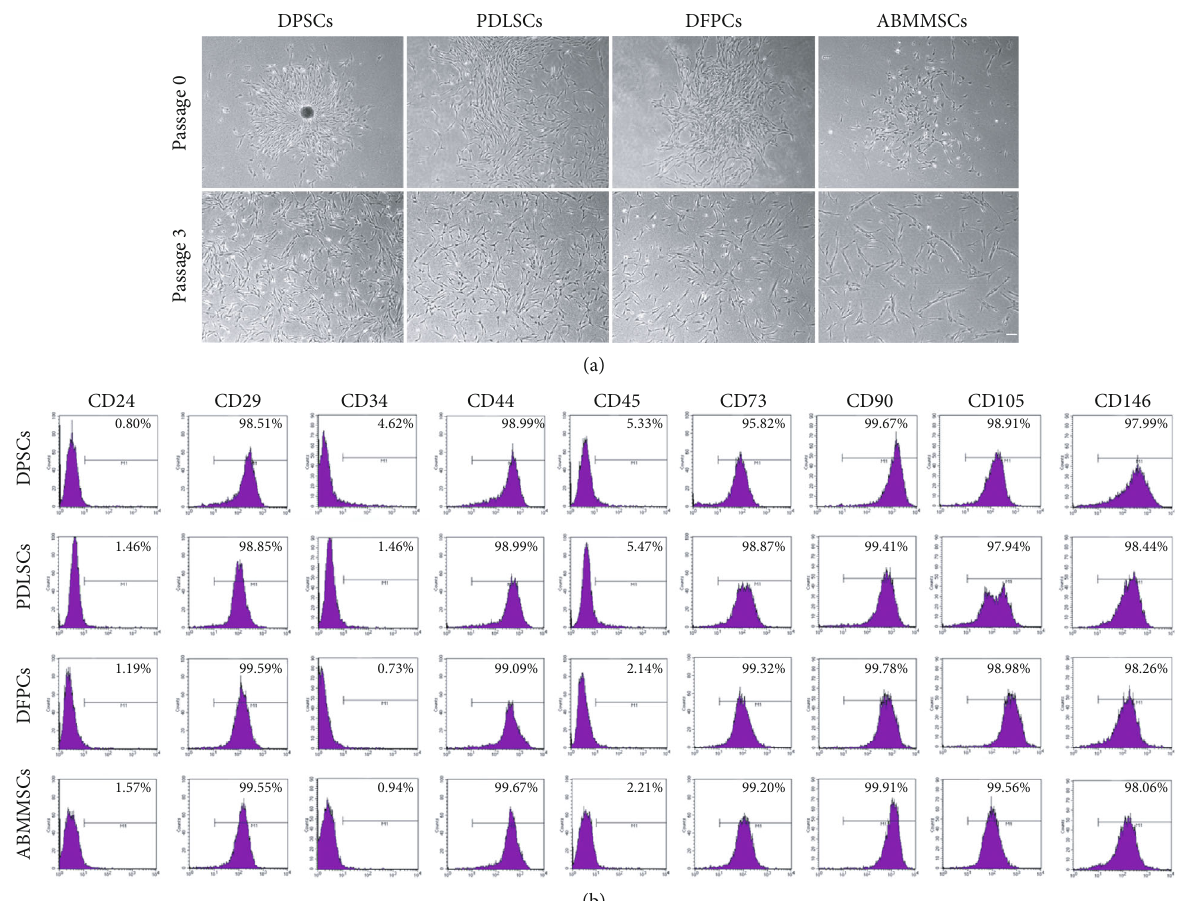
Figure 1: Morphology and immunophenotype of DPSCs, PDLSCs, DFPCs, and ABMMSCs. (a) Phase-contrast microscope images of MSCs at passage 0 and passage 3 ( scale bar = 1 mm, magnification = × 40 ). (b) Representative pictures of fl ow cytometric analysis of the surface marker expression on DPSCs, PDLSCs, DFSCs, and